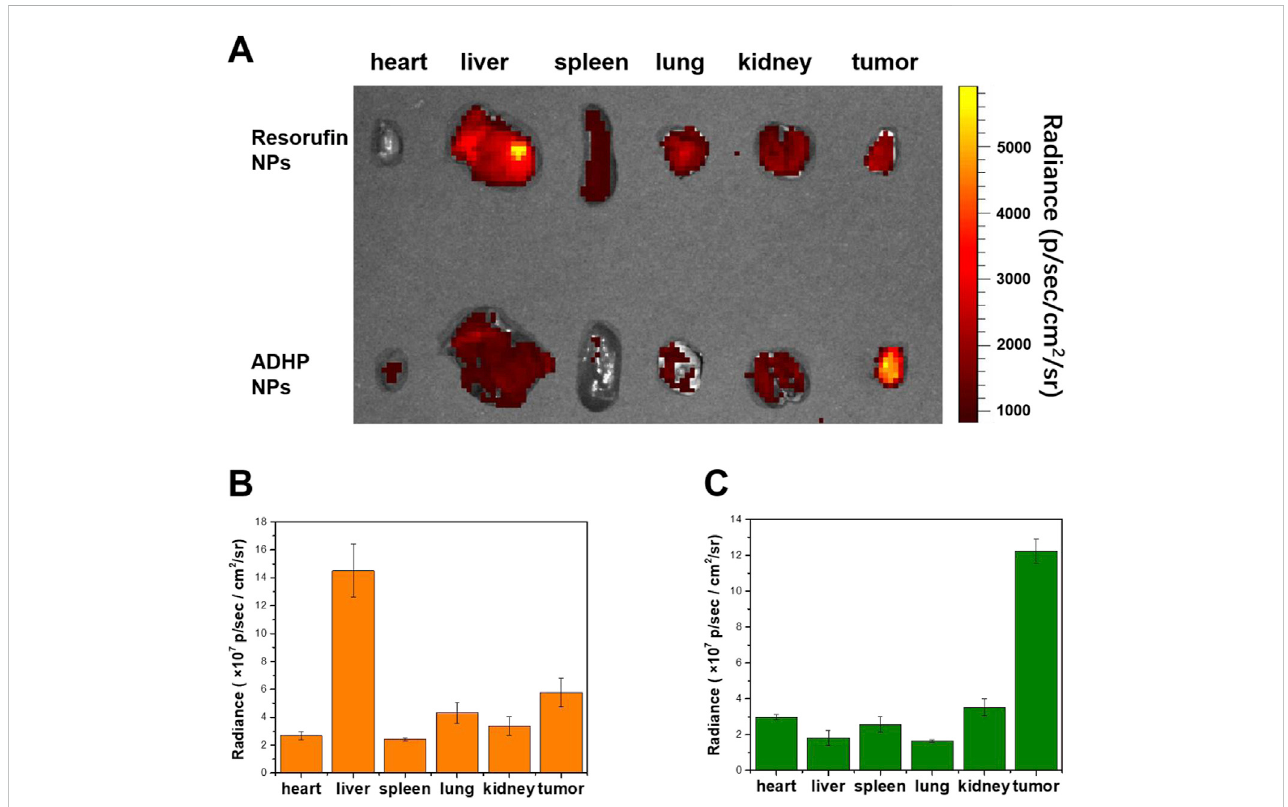
FIGURE 6 (A) Exvivo fl uorescenceimagingofseparatetissuesof4T1subcutaneoustumor-bearingmiceinjectedintravenouslyof200 μ LofADHPNPsorresoru fi n NPs (30 μ M based on each molecule) for 24 h. (B) Mean fl uorescent signals of dissimilar tissues based on the images in the resoru fi n NPs group. (C) The average fl uorescent signals in dissimilar tissues based on the images in the ADHP NPs